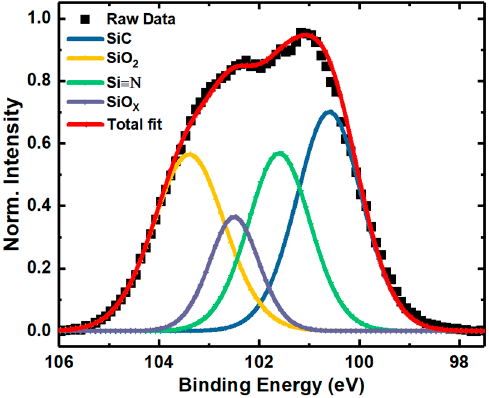
Figure 9. Si 2p core level XPS spectrum at the near interface of the samples without irradiation.